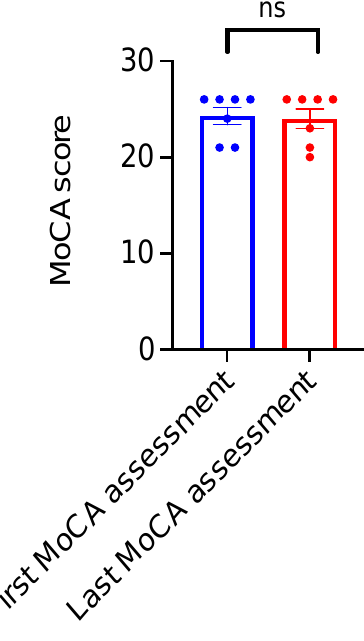
Figure 4. Assessment of participants’ cognitive functions over the course of VR-based environmental enrichment training based on Montreal cognitive assessment (MoCA). MoCA scores of the participants before (first MoCA assessment) and after (last MoCA assessment) the VR-based environmental enrichment training over 6 months do not significantly differ (Paired t test, t = 1.55, df = 6, ns indicates p = 0.1723, n = 7). Error bars indicate standard error means.